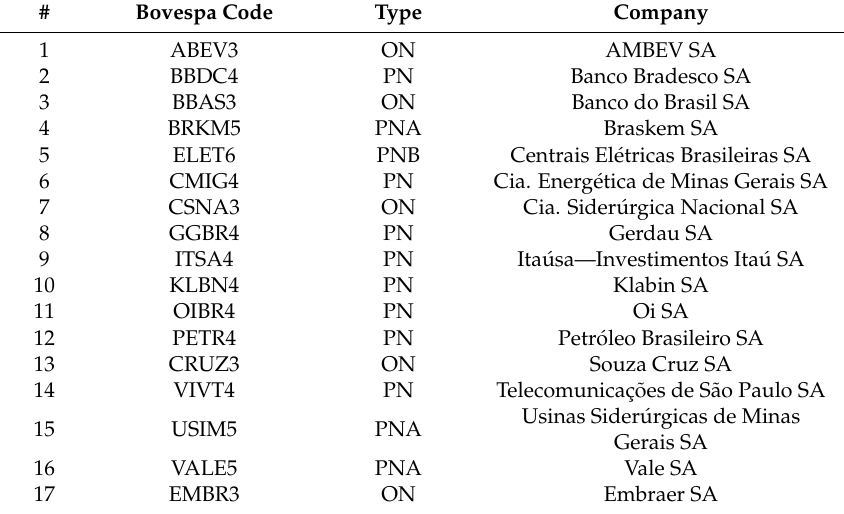
Table 1. Selected